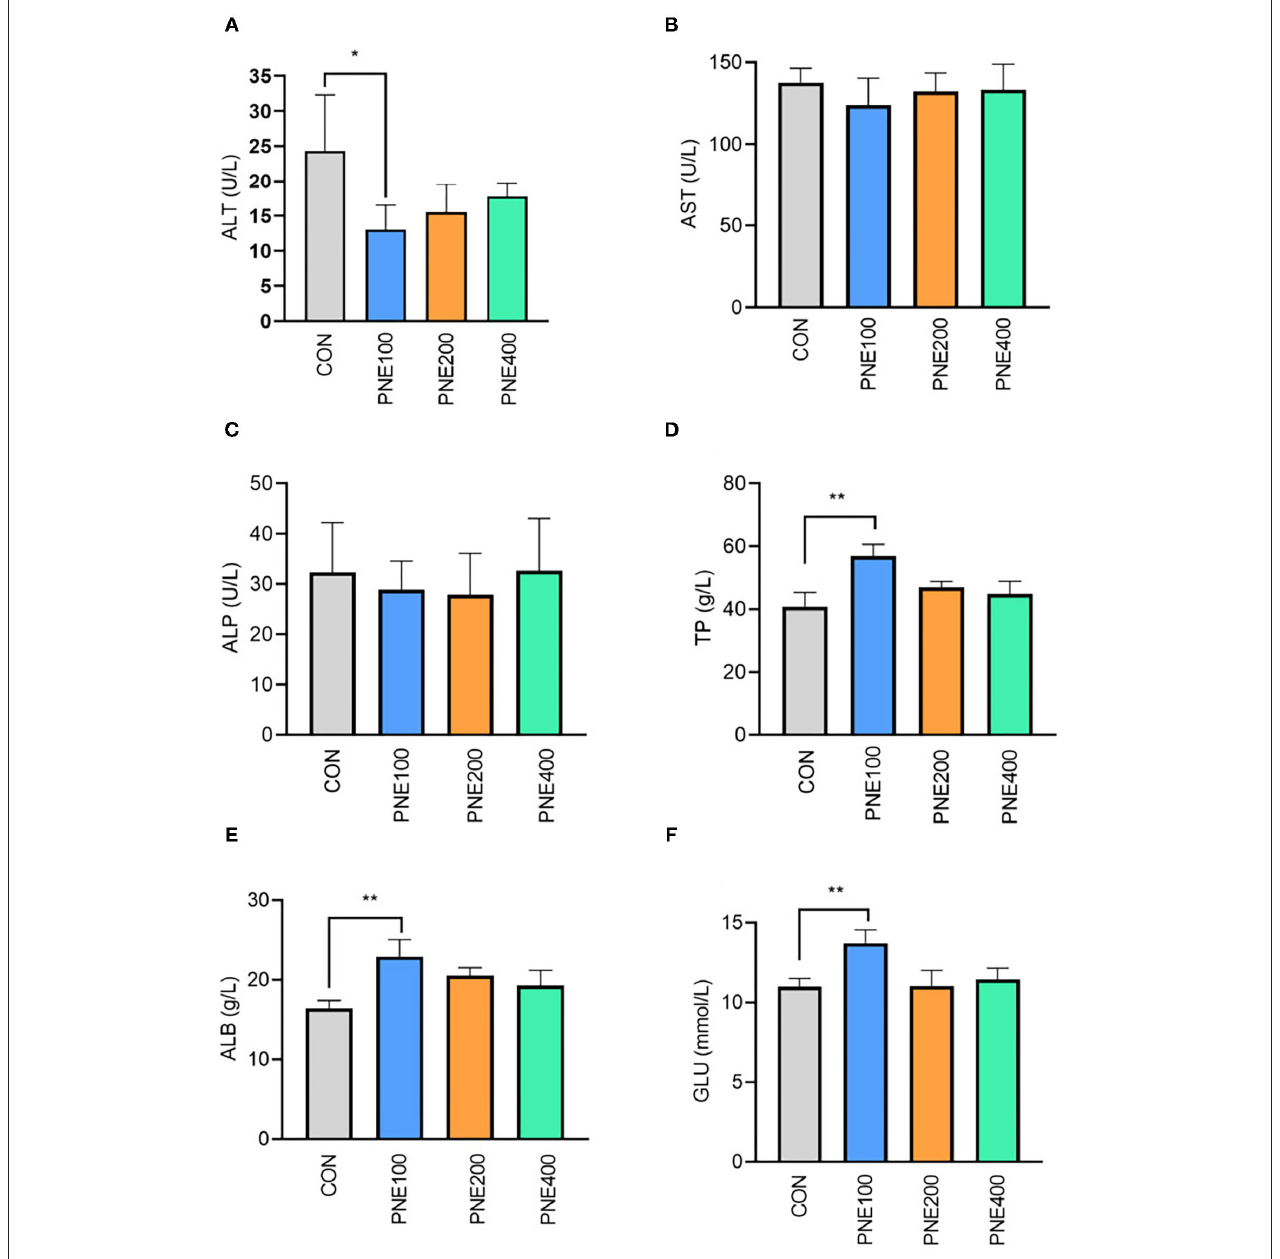
FIGURE 1 | Effect of pine needle extract (PNE) supplementation on serum biochemical indices ALT (A) , AST (B) , ALP (C) , TP (D) , ALB (E) , and GLU (F) of laying hens. ALT, alanine aminotransferase; AST, aspartate aminotransferase; ALP, alkaline phosphatase; TP, total protein; ALB, albumin; GLU, glucose. Asterisks denote significant differences (* p ≤ 0.05, ** p ≤ 0.01), n = 6 per group, data are expressed as means ±